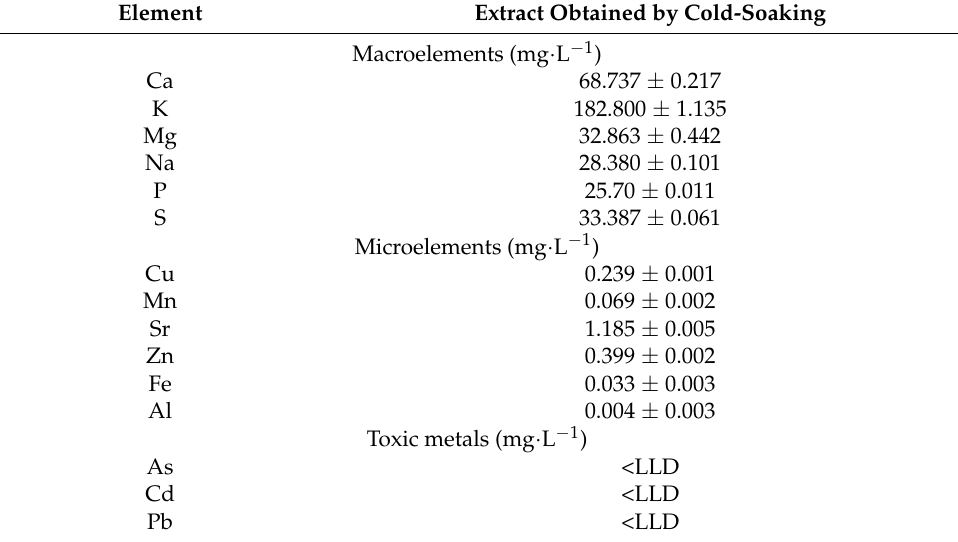
Table 1. Multielemental composition of water extract from L. usitatissimum (average ± SD).